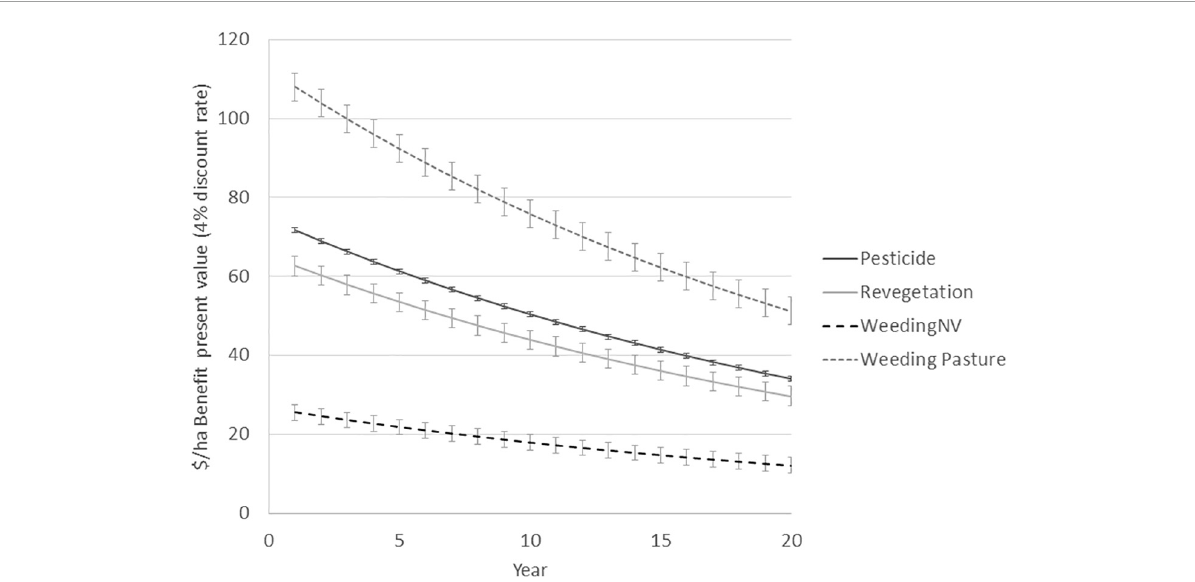
FIGURE5 Mean annual benefit ($) in present value across the landscape for mean parameter values of each management scenario over time in comparison to the null (no management) model, including an annual discount rate of 4% on the benefit [error bars indicate standard error of benefit ($) between canola fields in the landscape].